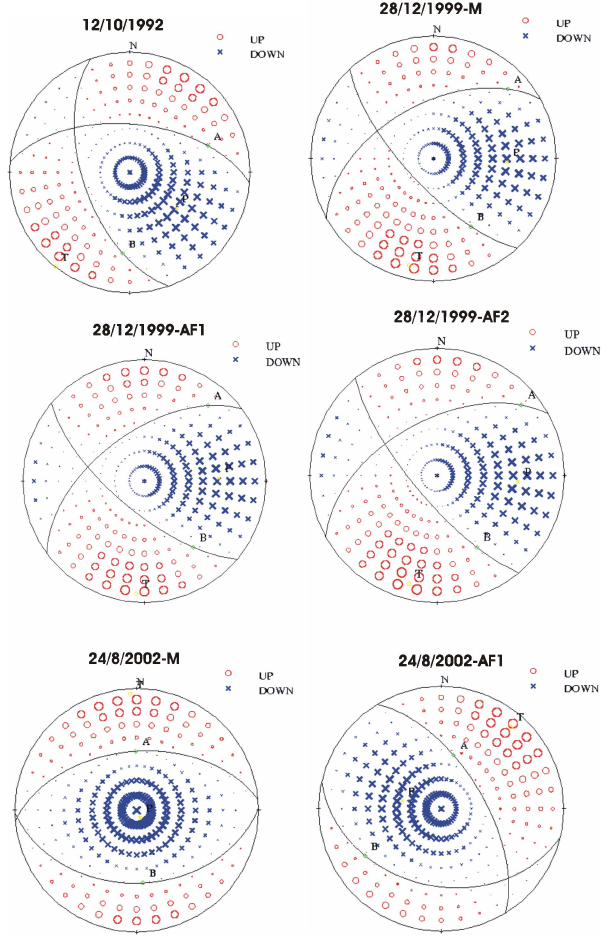
Fig. 6. Focal mechanism and radiation pattern of: 1) 28 December 1999 earthquake and its aftershocks (seismogenic zone 1), 24 Au- gust 2002 earthquake and its aftershock (seismogenic zone 2), and 3) 12 October 1992 earthquake (seismogenic zone 3). Focal mecha- nism based on the polarities of P-wave and lower hemisphere equal area projection is used.